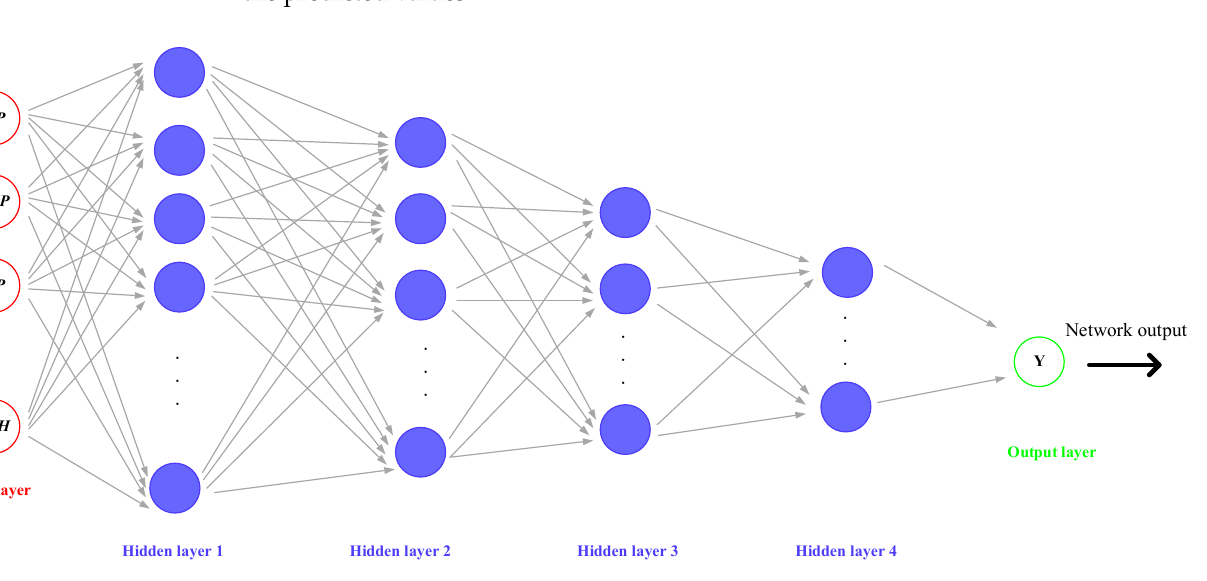
where Y is the vector of observed values of the variable being predicted, and ˆ Y represents the predicted values.